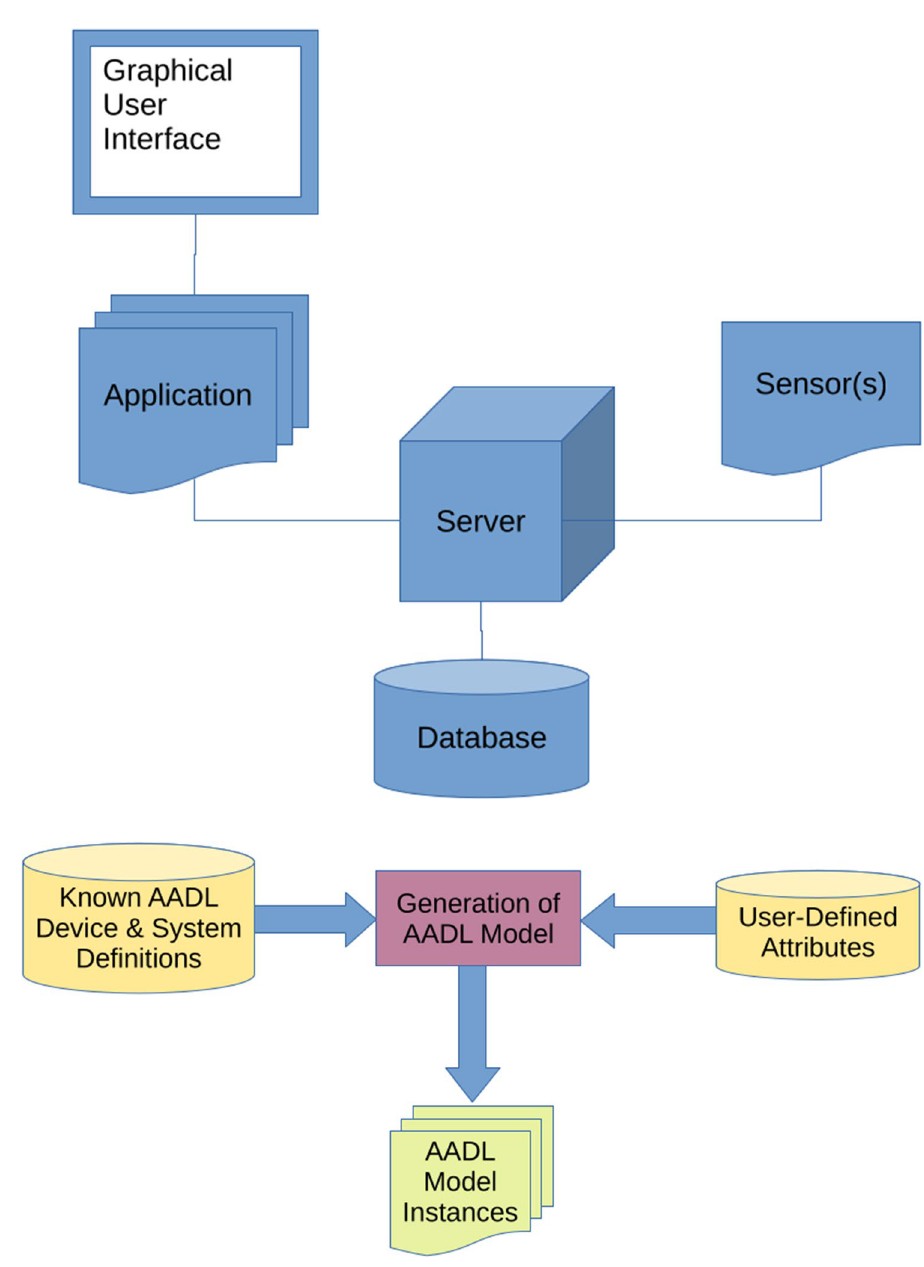
Fig. 2 Illustration of the basic IoT home model